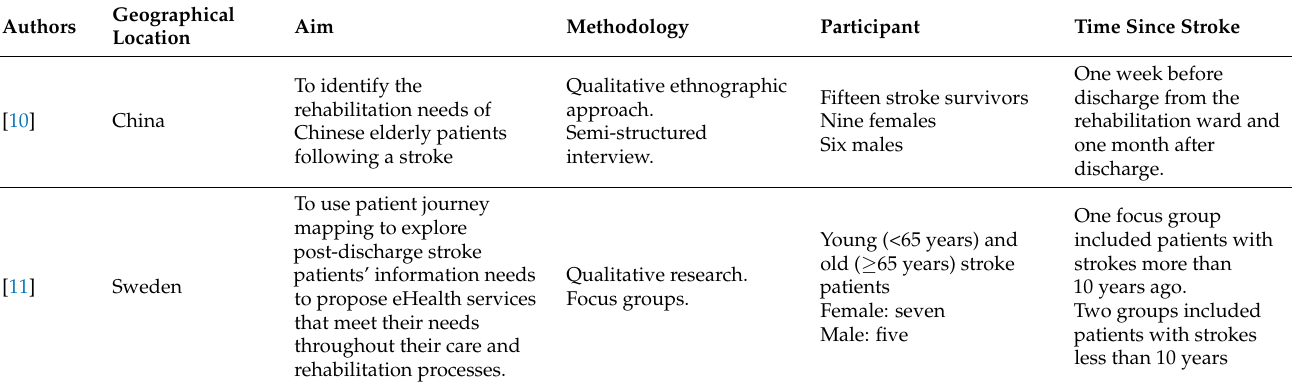
Table 1. Characteristics of